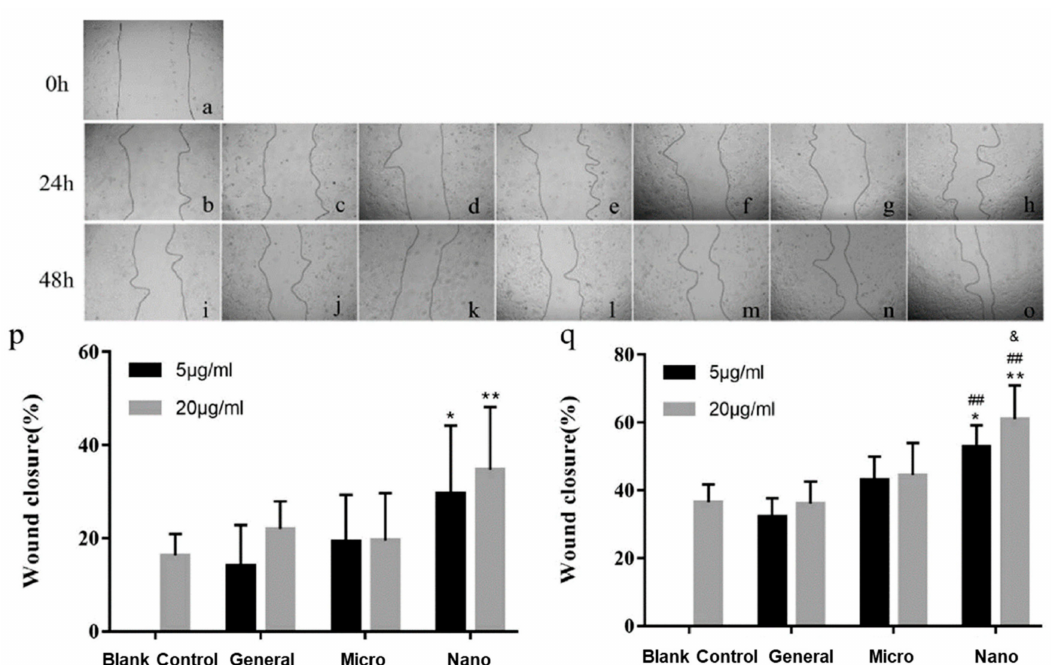
Figure 3. Different concentration and particle sizes of pearl powder and their effects on keratinocyte migration: ( a ) injury at 0 h; ( b , i ) control group; ( c , j ) pearl powders with concentration of 5 µ g/mL; ( d , k ) pearl powders with concentration of 20 µ g/mL; ( e , l ) micron-sized pearl powders with concentration of 5 µ g/mL; ( f , m ) micron-sized pearl powders with concentration of 20 µ g/mL; ( g , n ) nano-sized pearl powders with concentration of 5 µ g/mL; ( h , o ) nano-sized pearl powders with concentration of 20 µ g/mL. Statistical data of injury closure percentage in wound scratch assay in ( p ) 1 day and ( q ) 2 days, determined by Image J software (U.S. National Institutes of Health, Bethesda, MD, USA, v1.51 23 April 2018). Reproduced from [4]. (* p < 0.05, vs. blank control; ** p < 0.01, vs. blank control; ## p < 0.01, vs. general; & p < 0.05, vs.